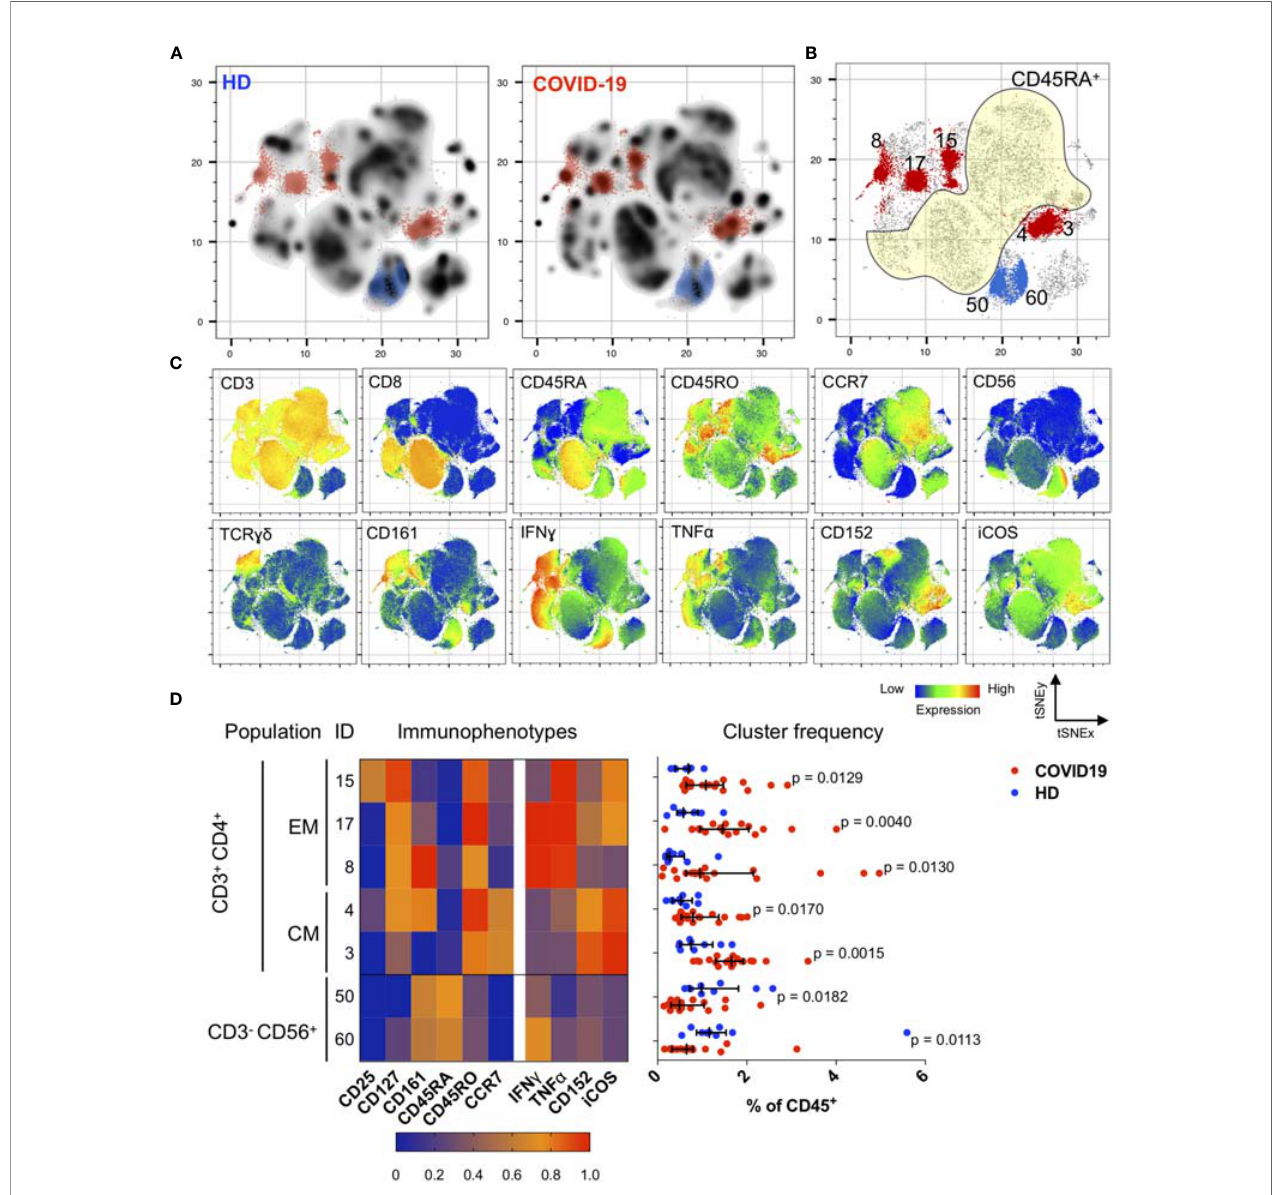
FIGURE 2 | Immunological changes in the memory compartment (CD45RO + CD45RA - ) of the CD3 + CD4 + cell subsets bear mechanistically important functional markers during the convalescent phase. (A) Density plots after t-SNE dimensional reduction show a convalescent immunome with visible differences when compared to the healthy immunome. Each density plot is derived from random sampling of 50,000 single events from concatenated mass cytometry data from 9 HD and 1019 COVID-19 subjects for their respective plot. (B) Persistent perturbations predominantly involve the CD45RO + CD45RA - CD3 + CD4 + (outside yellow demarcated area) T cell subset. Clusters showing statistically signi fi cant differences are coloured blue (enriched in HD) or red (enriched in disease). These regions are overlaid onto the density plots in (A) . Scatter plot of 280,000 single cell events with 10,000 per subject (n = 19, COVID-19 and n = 9, HD). (C) t-SNE with embedded marker expression. (D) Scaled median (arcsine transformed) marker expression pro fi les (heat maps) of signi fi cant FlowSOM clusters and their frequencies depicted as a percentage of CD45 + PBMC (n = 19, COVID-19 and n = 9, HD). Median and IQR are shown. Mann – Whitney U (two-tailed) test, p < 0.05 for these seven clusters. Stimulated PBMCs (with PMA and ionomycin) were stained with COVID-19 panel (A) ( Supplemental Table 1